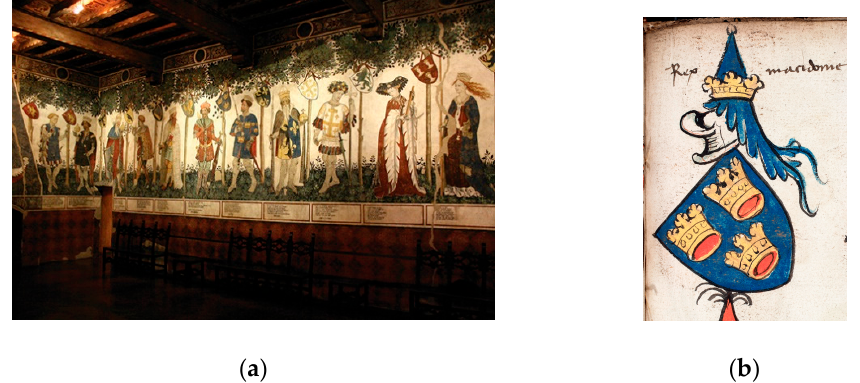
Figure 7. ( a ) Monti Castle, Italy; ( b ) Arms of King of Macedonia, High Almain Roll. The majority of these depict lions in one of the three heraldic poses: a lion rampant (including holding an axe) is the most frequent; then a lion seated on a throne holding an axe; or, most rarely, two lions combatant. The color of the shield is usually red or gold, sometimes blue or silver. The lion, however, usually appears in gold, then red, and least often silver, blue, or black. Nacevski considered 35 works with heraldic illustrations